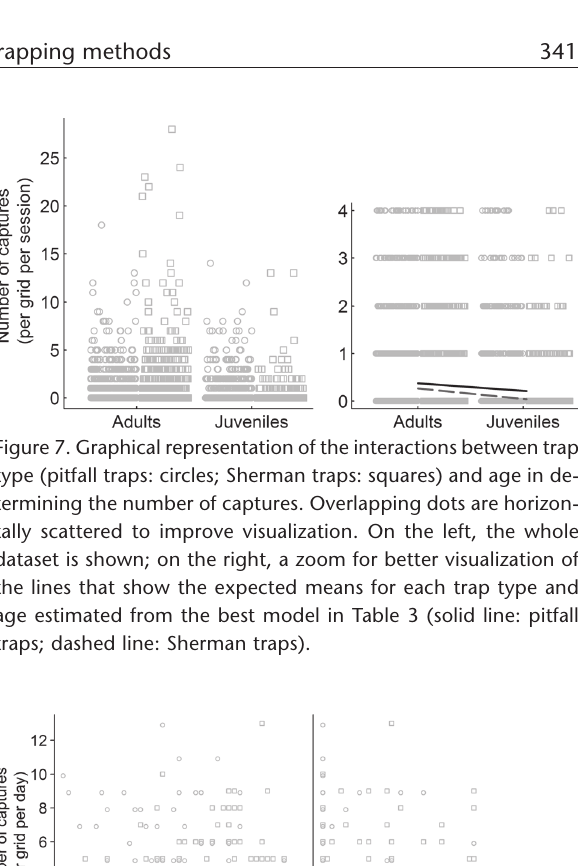
and Sherman traps. Overlapping dots are horizontally scattered to improve visualization. Two data-subsets were used for Sherman traps: only captures from Sherman traps placed adjacent to pitfall lines (column A) or from Sherman traps intercalated with pitfall lines (column B). Colored lines: random effects of